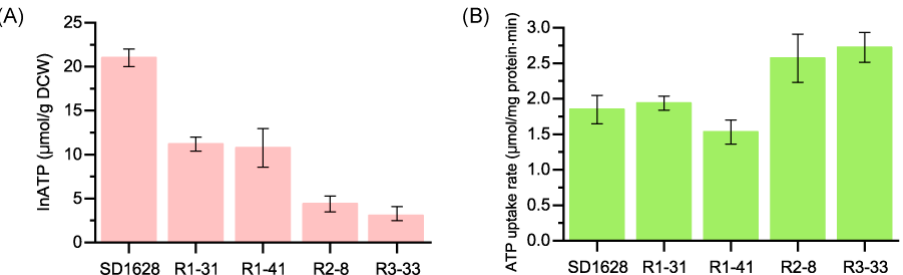
Figure 4. The intracellular ATP level and ATP hydrolysis rate in vitro in wild-type and its mutants. ( A ) The amount of inATP measured at 48 h; ( B ) the ATP hydrolysis rate of wild-type SD1628 and its